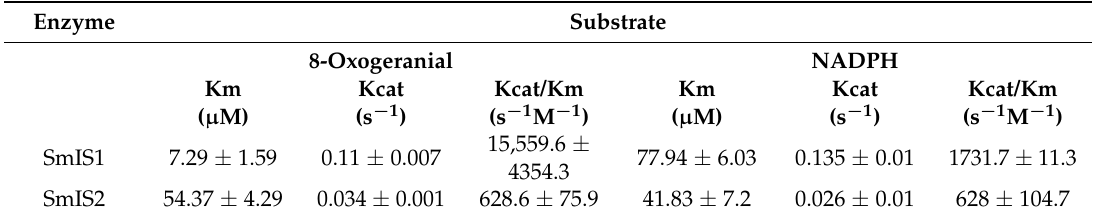
Table 1. Compared kinetic parameters of recombinant of SmIS1 and SmIS2.